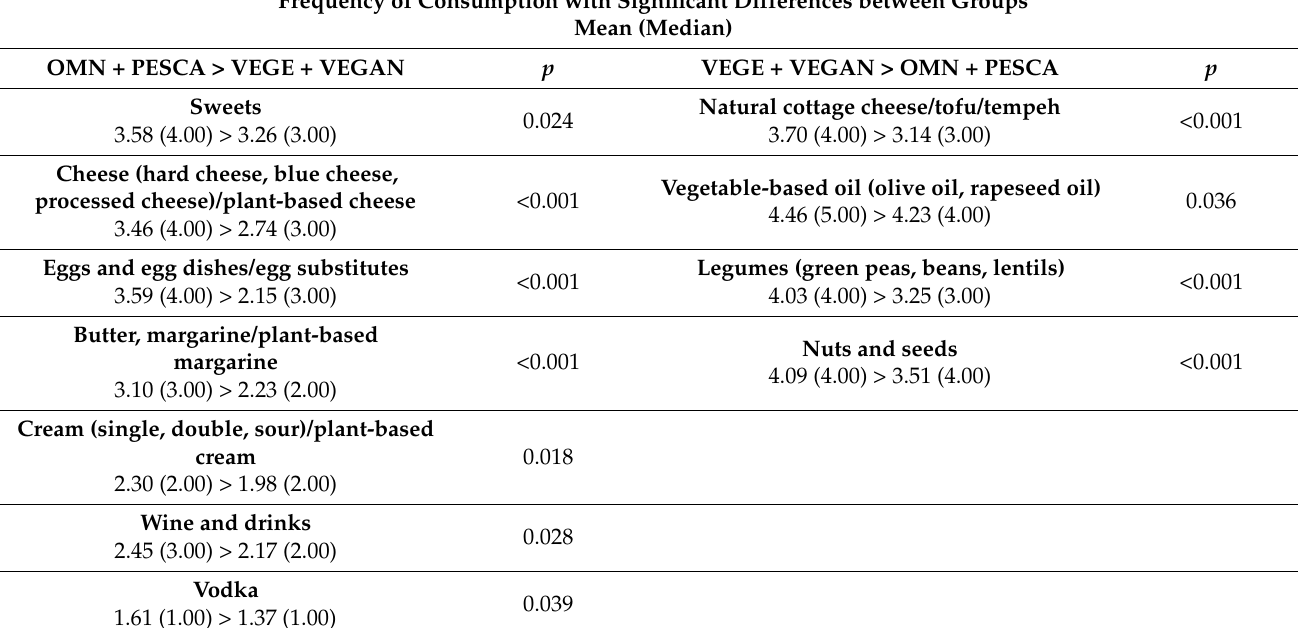
Table 7. Statistically significant differences in the frequency of consumption between the studied groups divided into two categories—OMN + PESCA (including meat consumption) and VEGE + VEGAN (not including meat